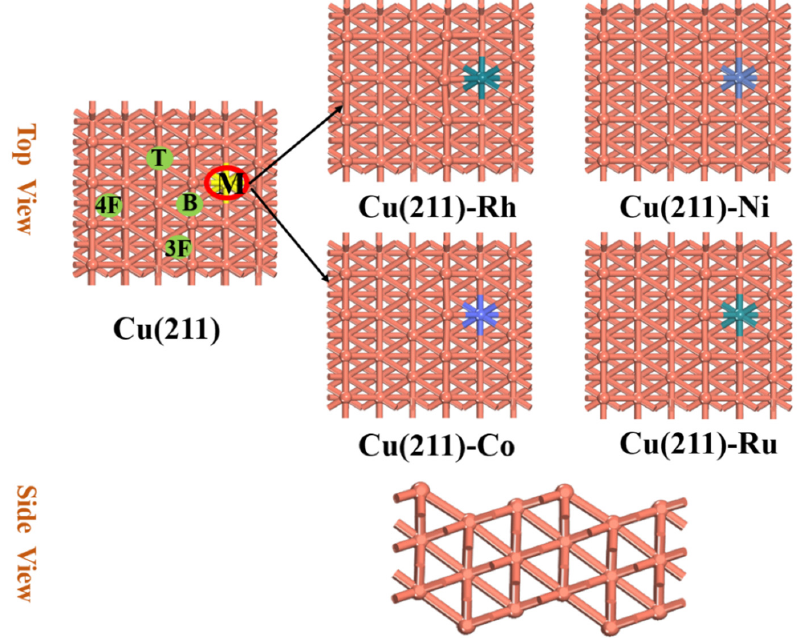
Figure 9. Top and side views of structures of pure Cu(211) surface and transition-metal-doped Cu(211)-M (M = Rh, Ni, Co, and Ru) surfaces and possible adsorption sites: top site (T), bridge site (B), three-fold site (3F), and four-fold site (4F).